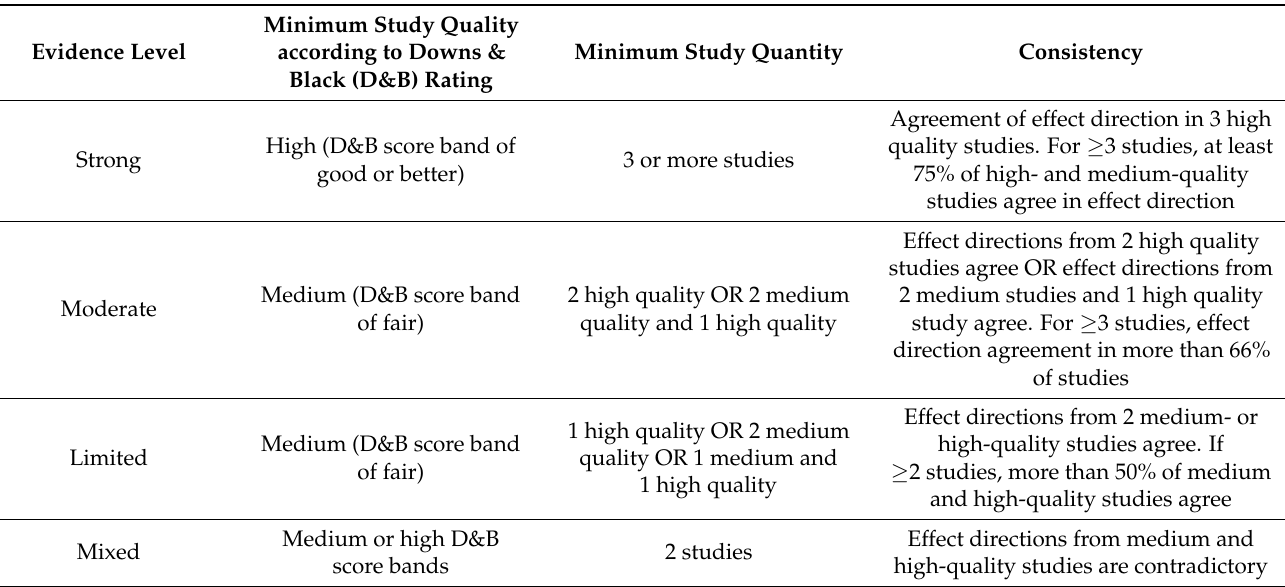
Table 1. Decision algorithm for level of evidence. Adapted from the Best Evidence Synthesis Guidelines used by Kennedy et. al